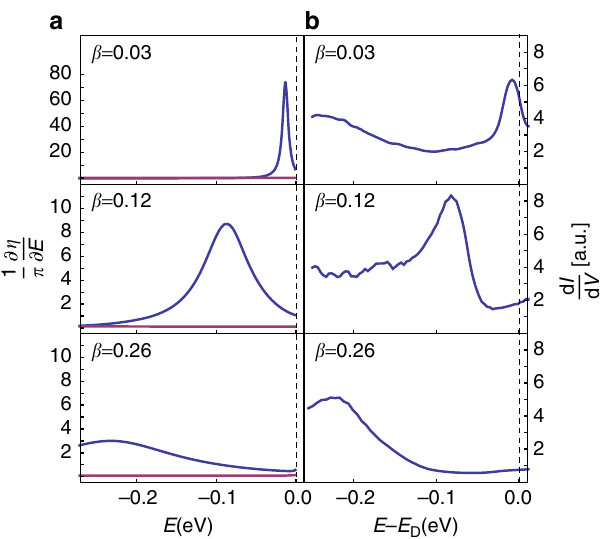
Fig. 2 Experimental and theoretical picture in the undercritical regime. a Theoretical behavior of (1)/( π )d η /d E for d = 2 showing quasi-bound states of a massless Dirac fermion in the undercritical regime β < 1/2. In the scale-free low-energy, EL (cid:6) 1 regime, the m = − 1 ( blue ) branch contains a single peak and the m = 0 (purple) branch shows no peak independently of the choice of boundary condition (see Supplementary Note 2). While increasing β , the resonance shifts to lower energy and becomes broader. b Excitation spectrum measured in graphene using STM as a function of the applied voltage V . The determination of the parameter β is explained